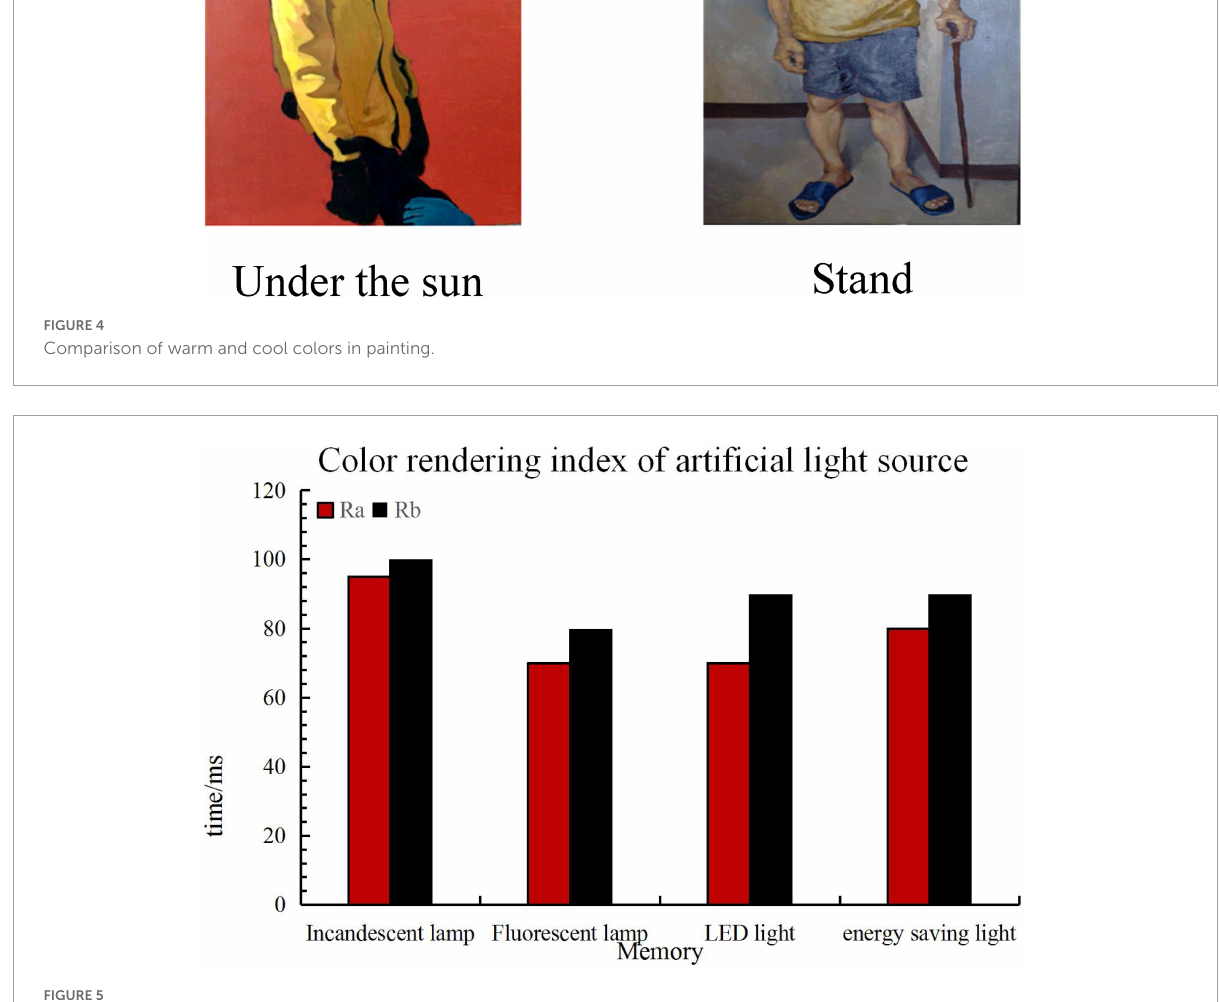
FIGURE5 Color rendering index of common indoor artificial light